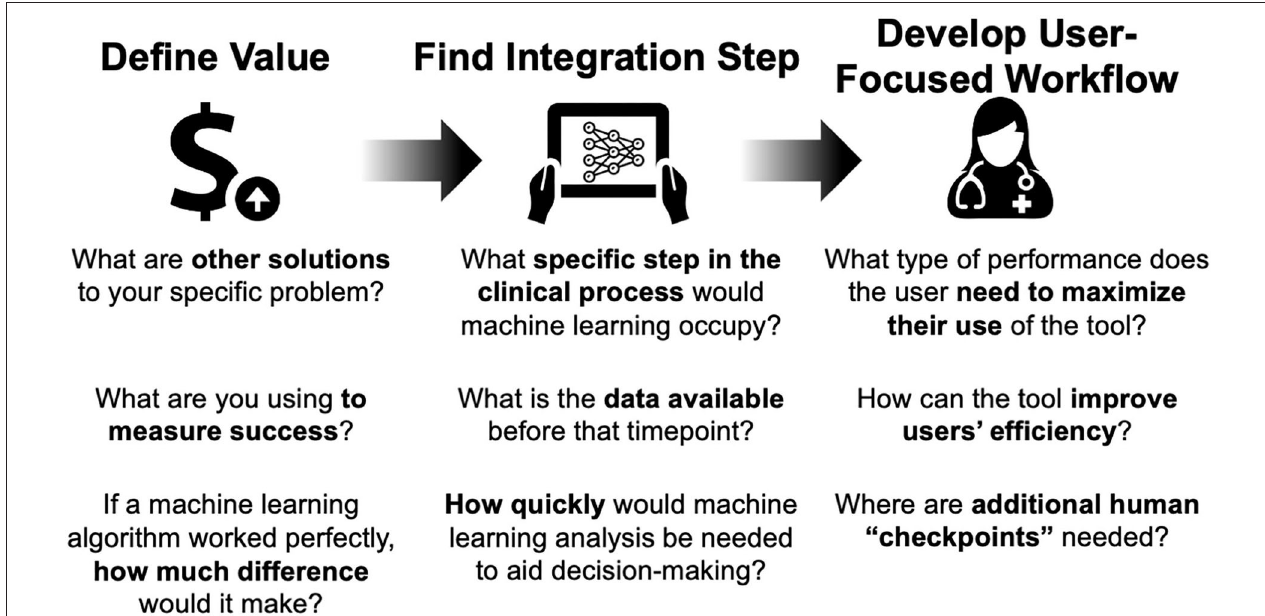
FIGURE 1 | Framework for considering artificial intelligence-based tools for clinical